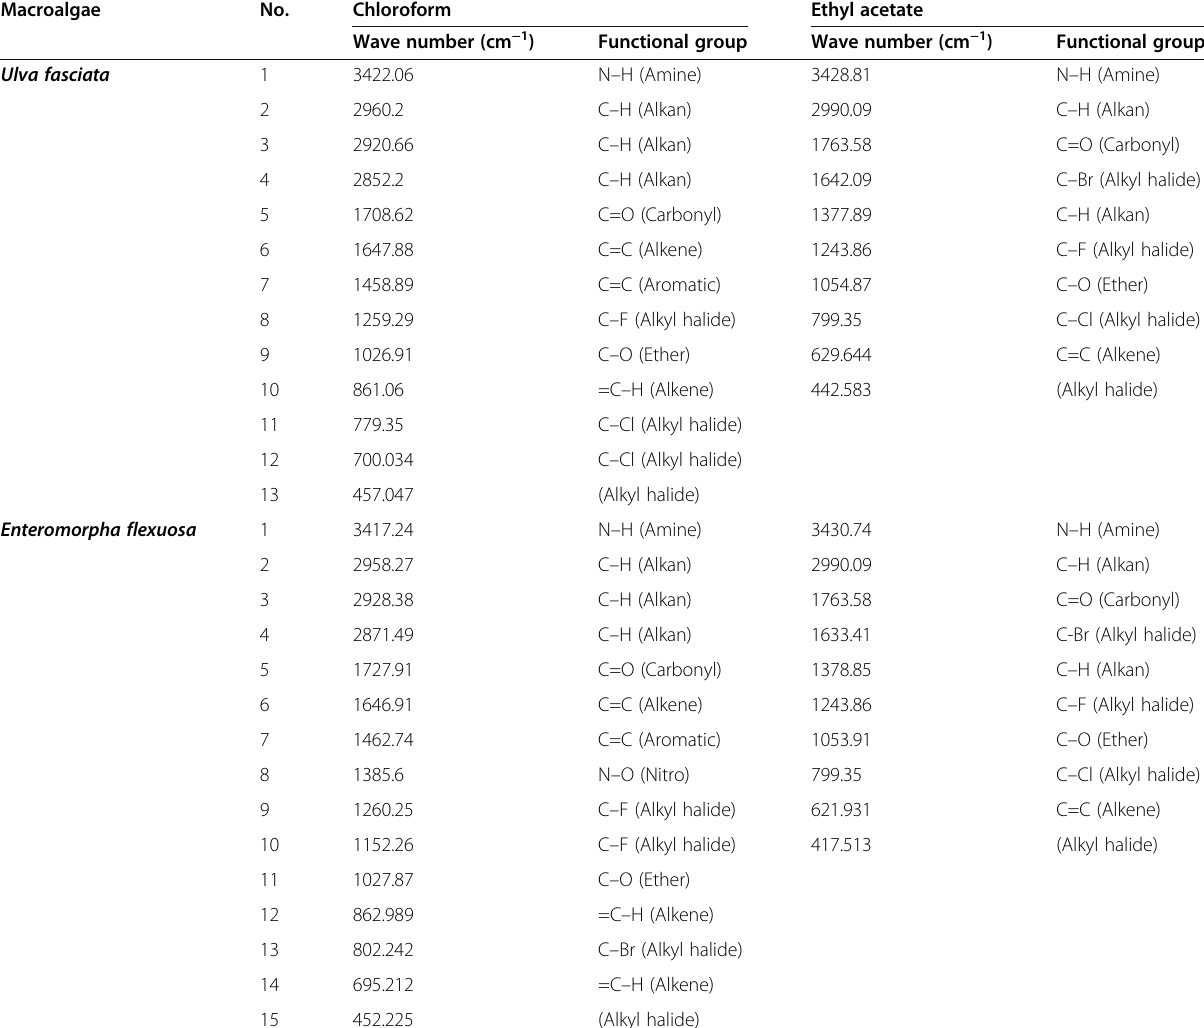
Table 2 Determination of chemical compounds of partially purified extract filtrate of chloroform and ethyl acetate from Ulva fasciata and Enteromorpha flexuosa using infrared (IR)